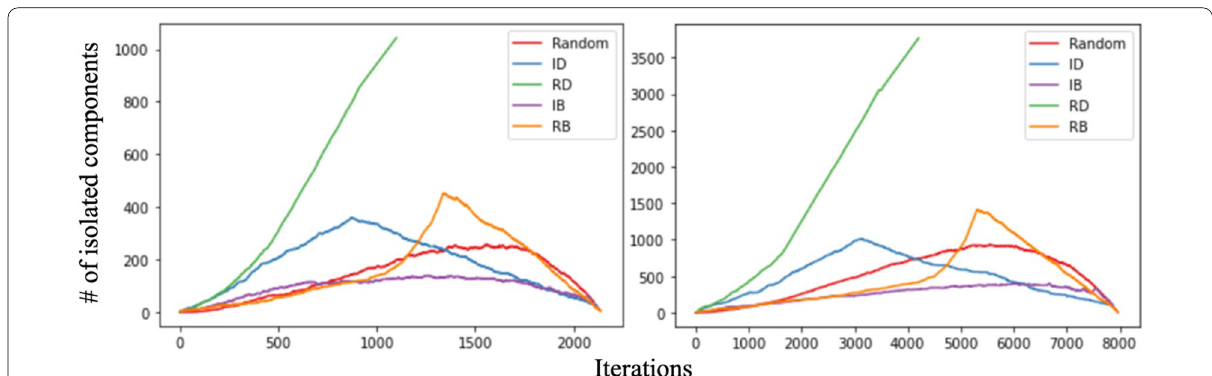
Fig. 12 Evolution of the Isolated components (IC) in the CARRIS layer (left) and multimodality network (right) for node removal